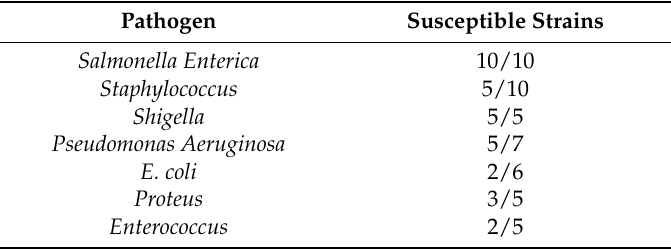
Table 5. Fraction of the strains found to be susceptible for each pathogen tested. Observe that this is only a small-scale experiment. All strains are part of an in-house